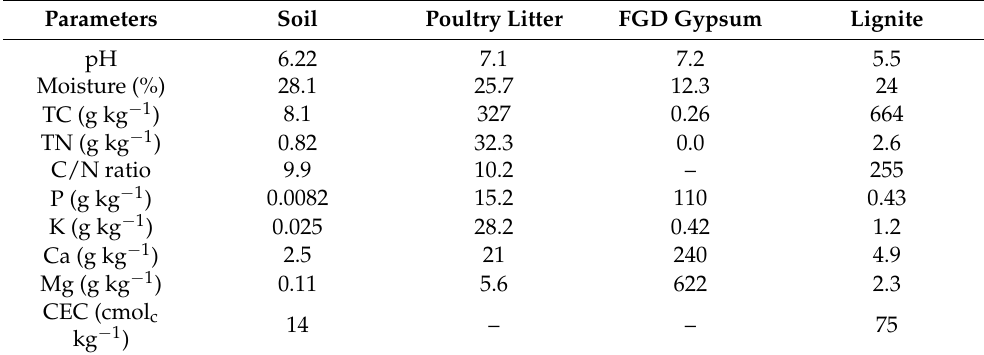
Table 1. Background chemical characteristics of soil at 0–15 cm depth and the mean of chemical properties of poultry litter, FGD gypsum and lignite across years.